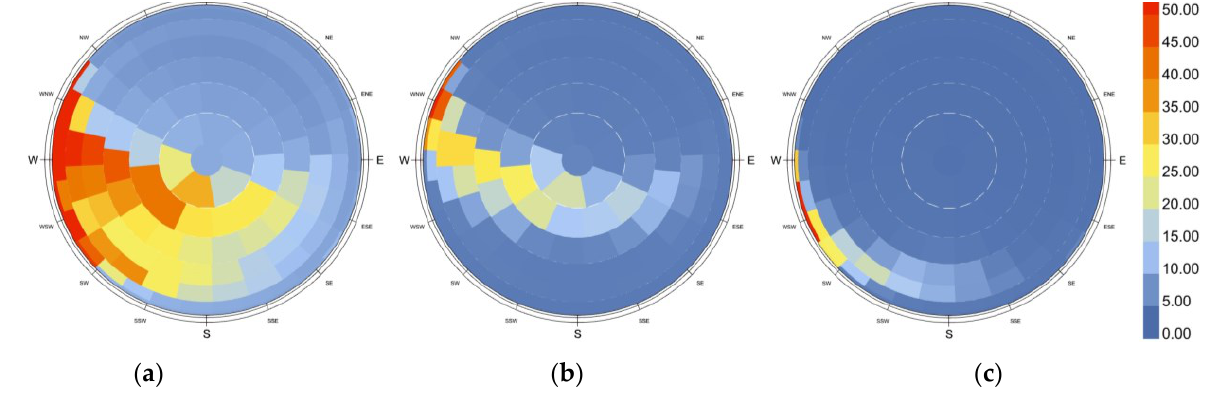
Figure 5. The Radiation intensity distribution model in Xi ’ an: ( a ) a-year-round radiation model; ( b ) high-temperature radiation model; ( c ) low-temperature radiation